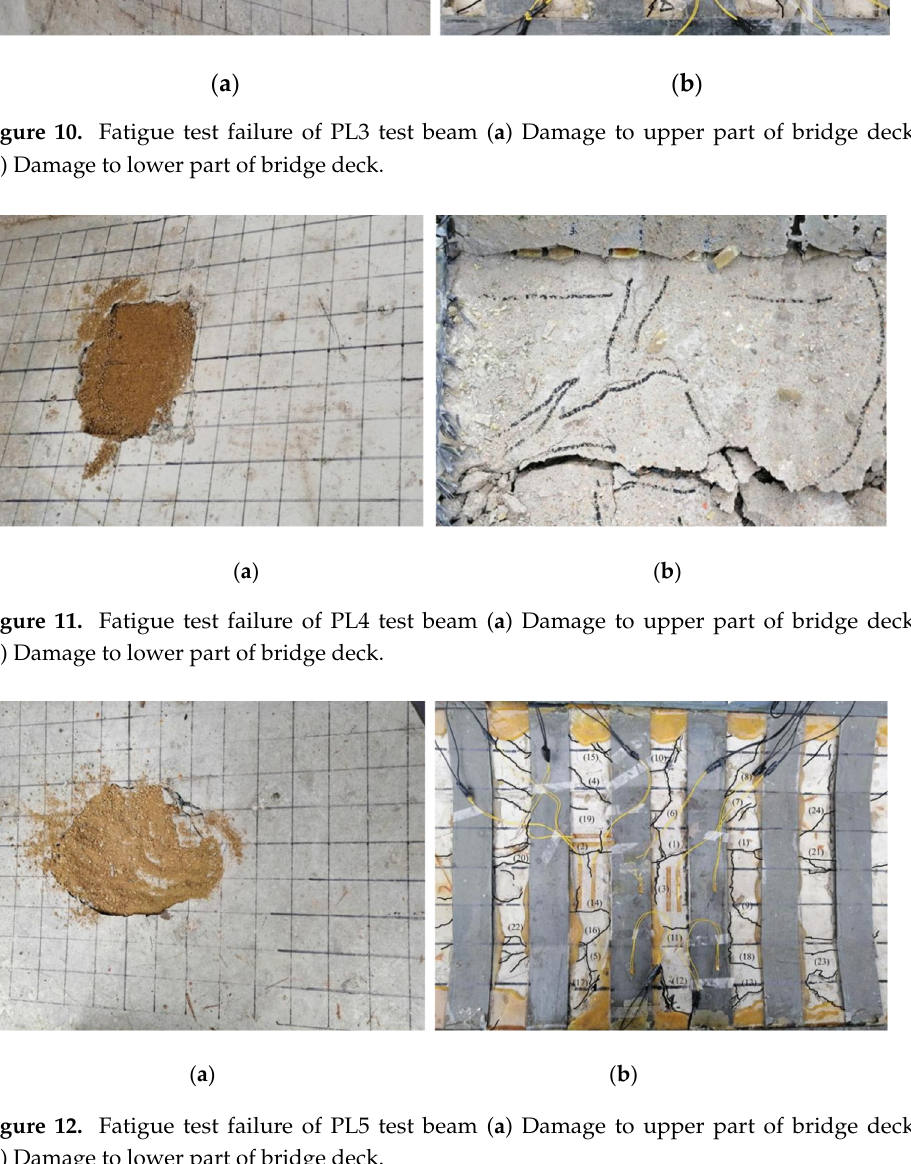
Figure 12. Fatigue test failure of PL5 test beam ( a ) Damage to upper part of bridge deck and ( b )